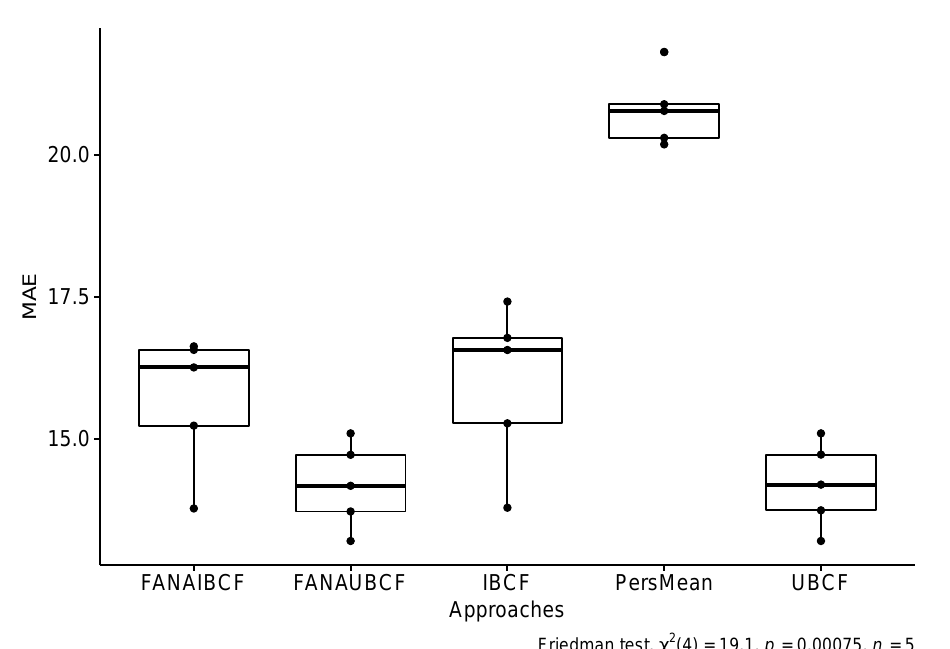
Figure 4. Box and whisker plot of MAE with Friedman test results. Note that a p value < 0.05 means the experimental result is statistically significant.